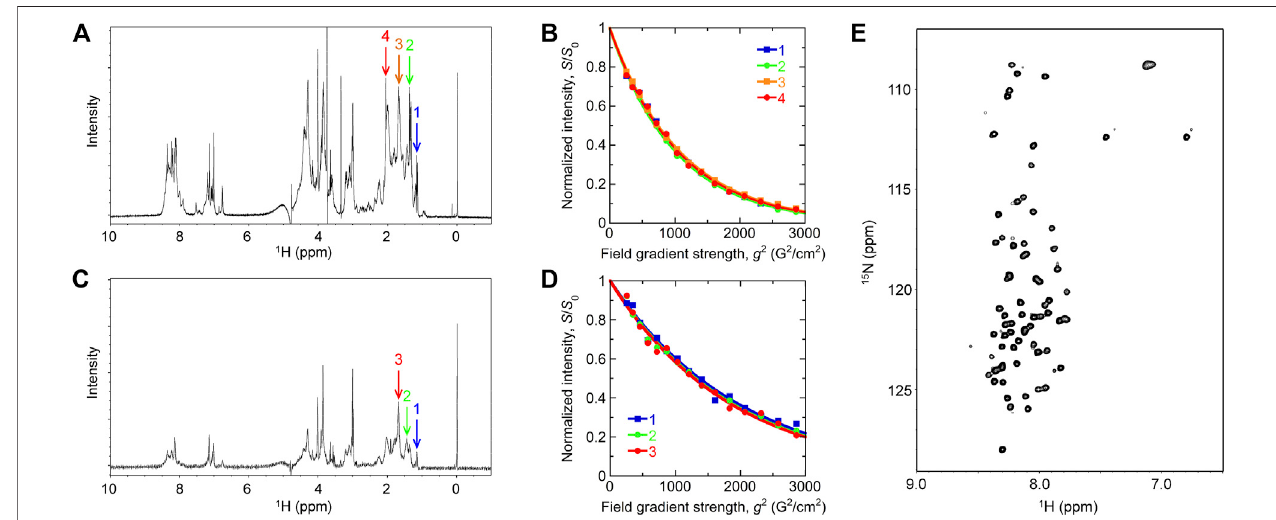
FIGURE 3 | NMR measurements. (A,C) One-dimensional NMR spectra of the wild type (A) and R371I mutant (C) of Int8. Arrows show the peaks used for the analysisofpulsed- fi eldgradient(PFG)NMRmeasurement.TheDSSpeakisat0 ppm. (B,D) PeakintensitydecaycurvesobtainedbythePFGNMRmeasurementofthe wild type (B) and R371I mutant (D) . (E) Two-dimensional 1 H − 15 N heteronuclear single quantum coherence spectrum of the wild-type